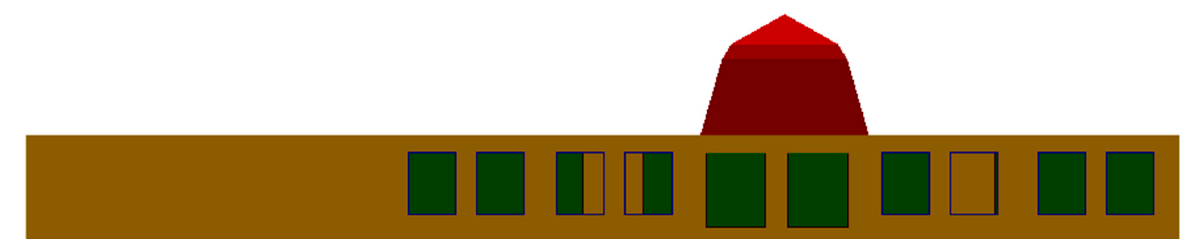
Figure 6. East elevation view of Hudhayfah mosque. The Qubba’s (Dome’s) maximum height is 9 metres, while the main prayer hall’s height is 4.2 metres.